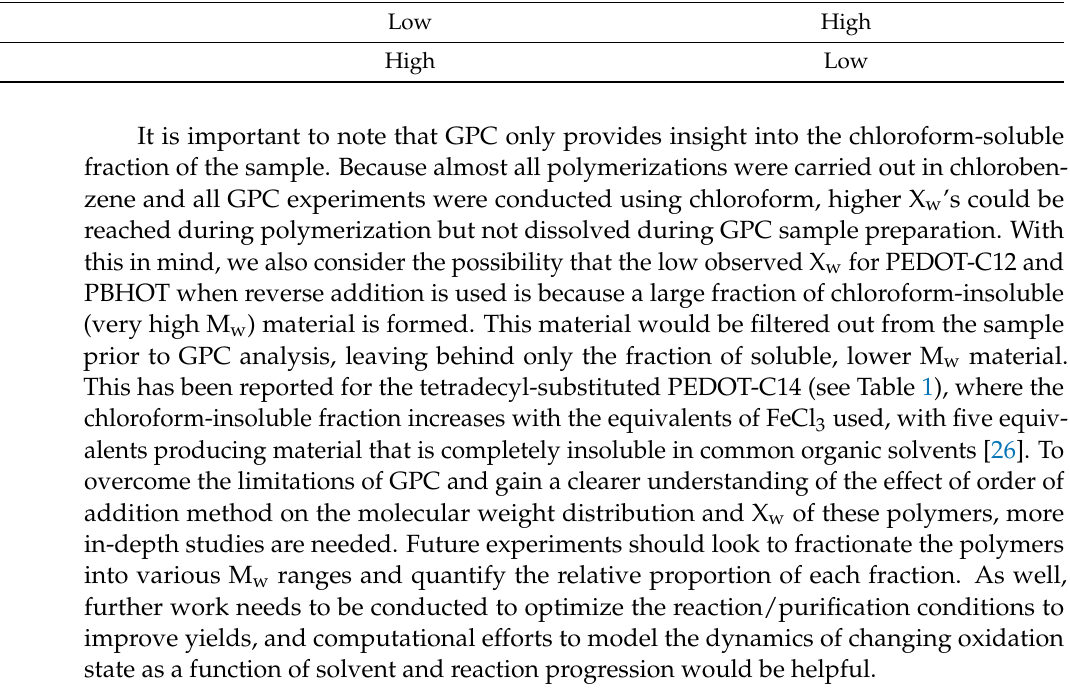
Table 4. Summary of differences between orders of addition and the trends observed for the ether-substituted polymers. Reverse Addition Standard Addition Binary mixture of chlorobenzene and Solvent Composition Pure chlorobenzene acetonitrile [FeCl 2 ] in Solution Low High Begins high and decreases to Begins low and increases to Relative Oxidant/Monomer Ratio theoretical value theoretical value Oxidation Potential of Solution High Low Polymerization Mechanism More step growth-like More chain growth-like X w Low High Yield High